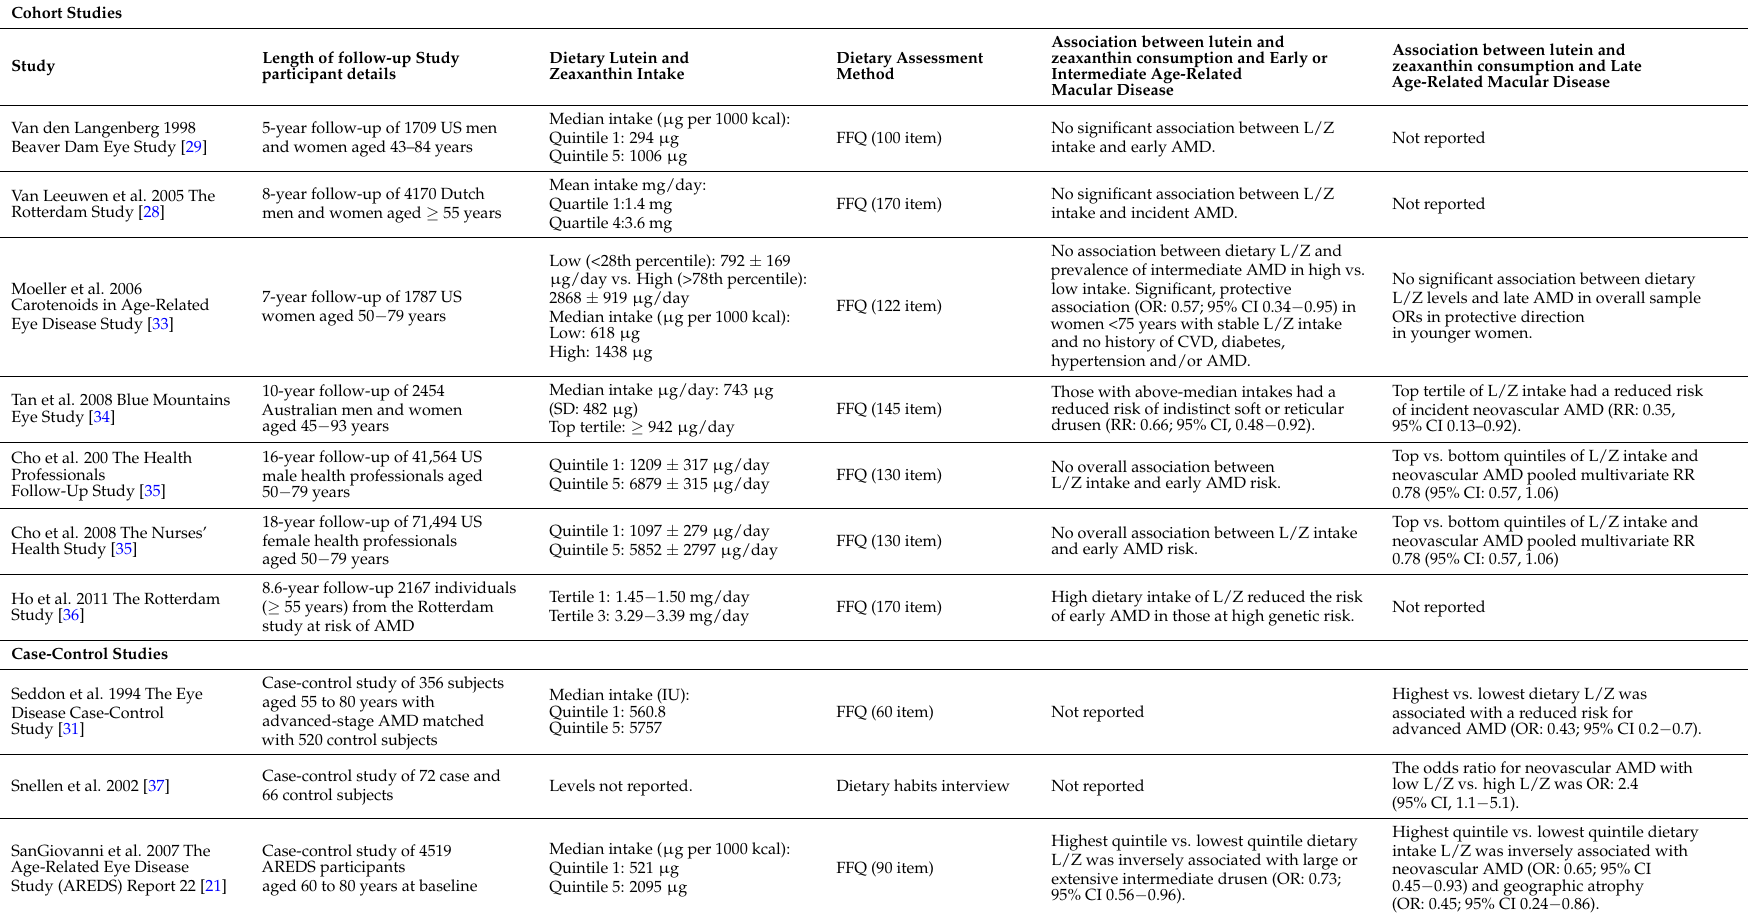
Table 2. Summary of epidemiological evidence of dietary lutein/zeaxanthin intake and age-related macular